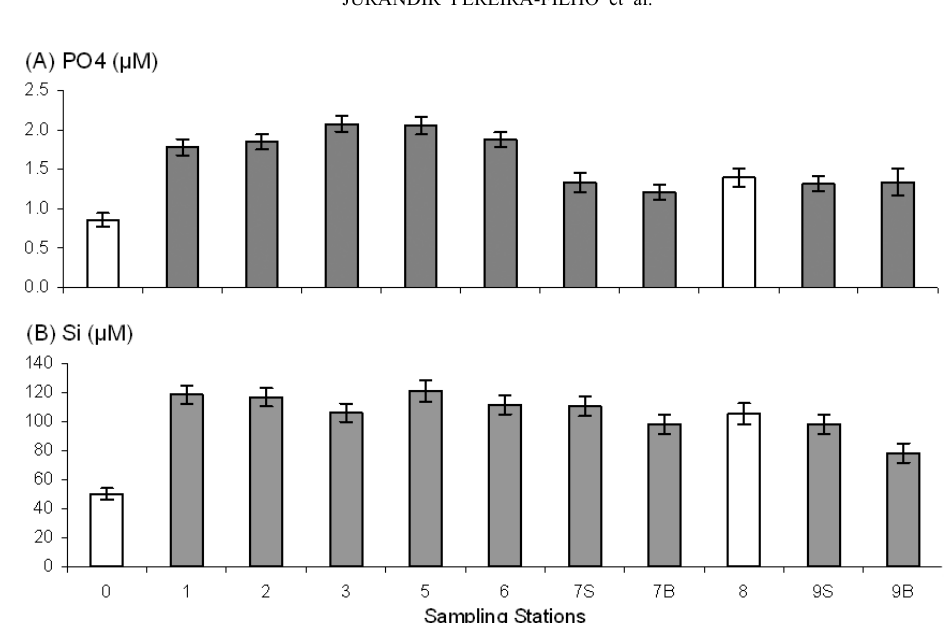
Fig. 4 – Spatial variation of (A) phosphate (PO 3 − 4 ) and (B) orthosilicic acid (H 4 SiO 4 ) in the fluvial-estuarine system of the Itajaí-Açú River. Overall average and Standard Error for each sampling station, for the entire period sampled (October 2003 to December 2004). The columns in gray represent the stations located in the estuary, and the others in